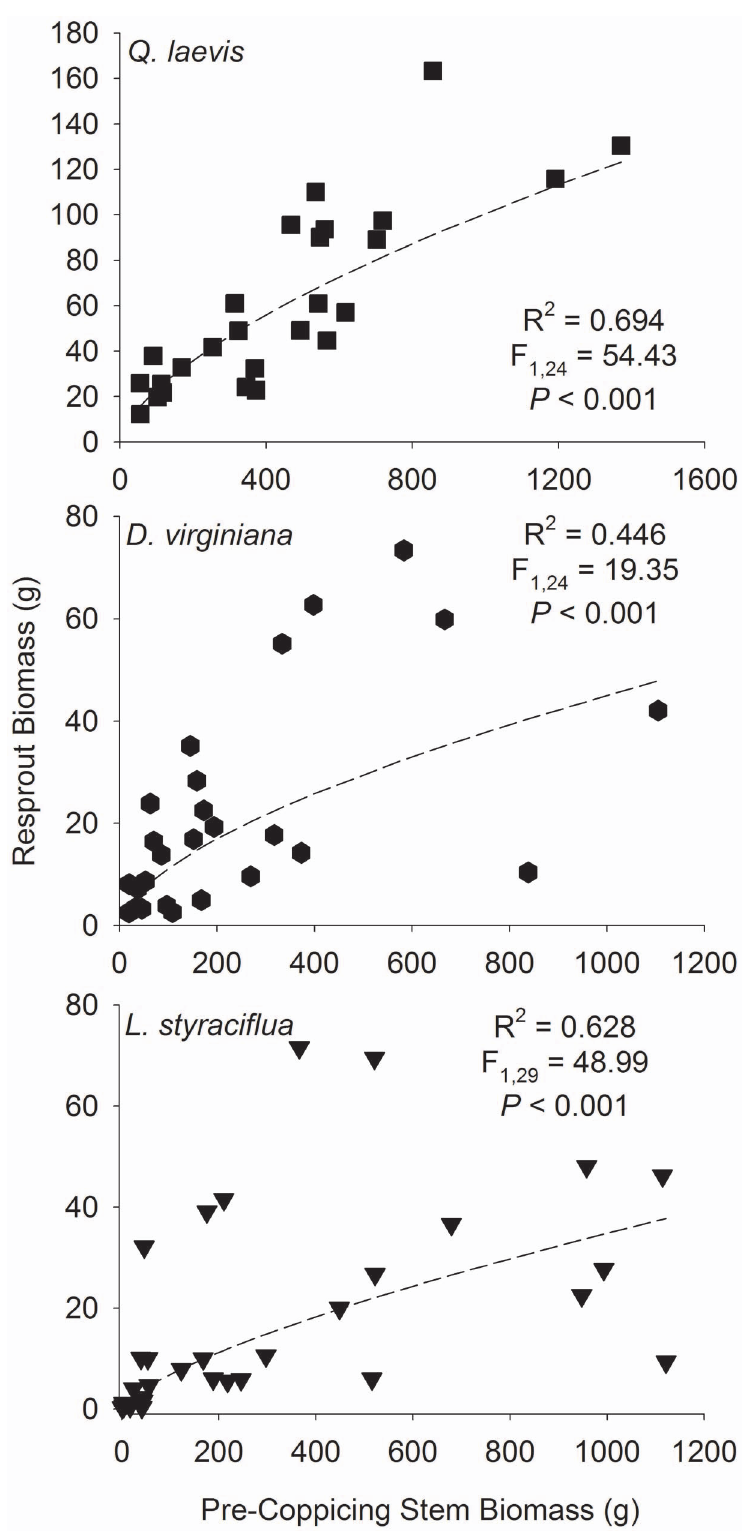
Figure 4. Curvilinear relationships between total pre-coppicing stem biomass and total resprout biomass.